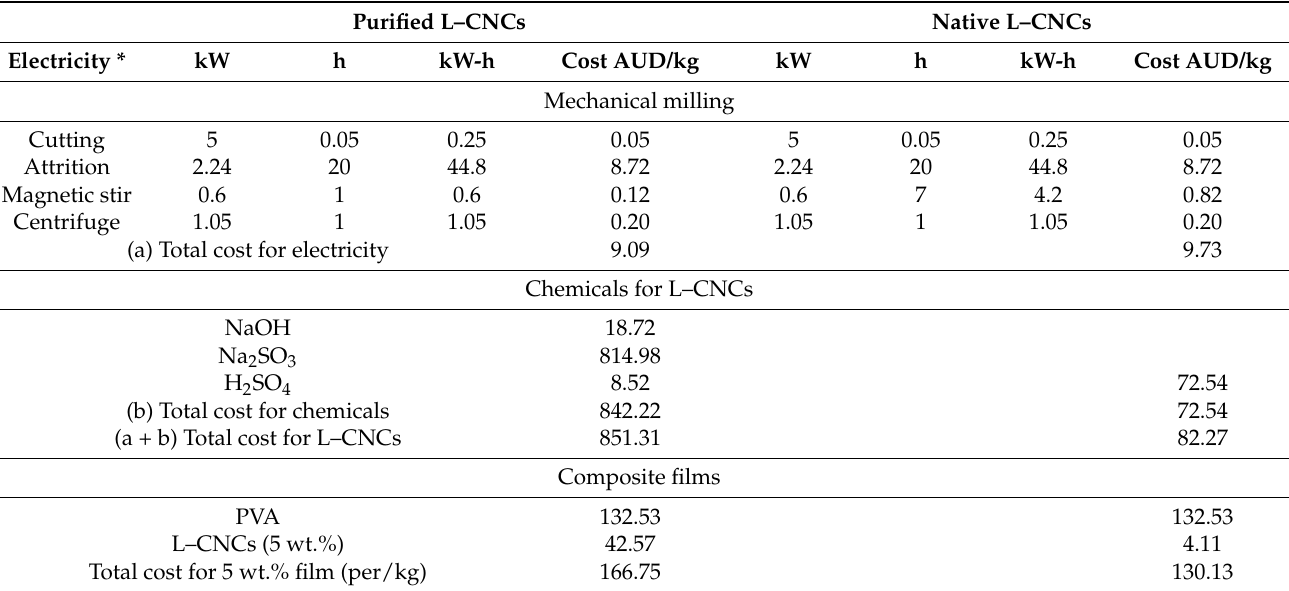
Table 3. Approximate cost to produce purified L–CNCs/PVA and native L–CNCs/PVA composite films on a laboratory